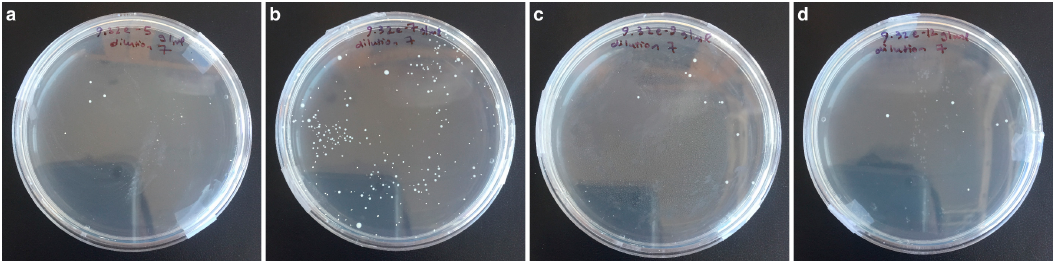
Figure 4. Example images of the bacteria count test after 5 h for samples: ( a ) 9 × 10 − 5 g/mL Cu ions, ( b ) 9 × 10 − 7 g/mL Cu ions, ( c ) 9 × 10 − 9 g/mL Cu ions, ( d ) 9 × 10 − 12 g/mL Cu ions. All after 7 iterative, 10-fold dilutions.